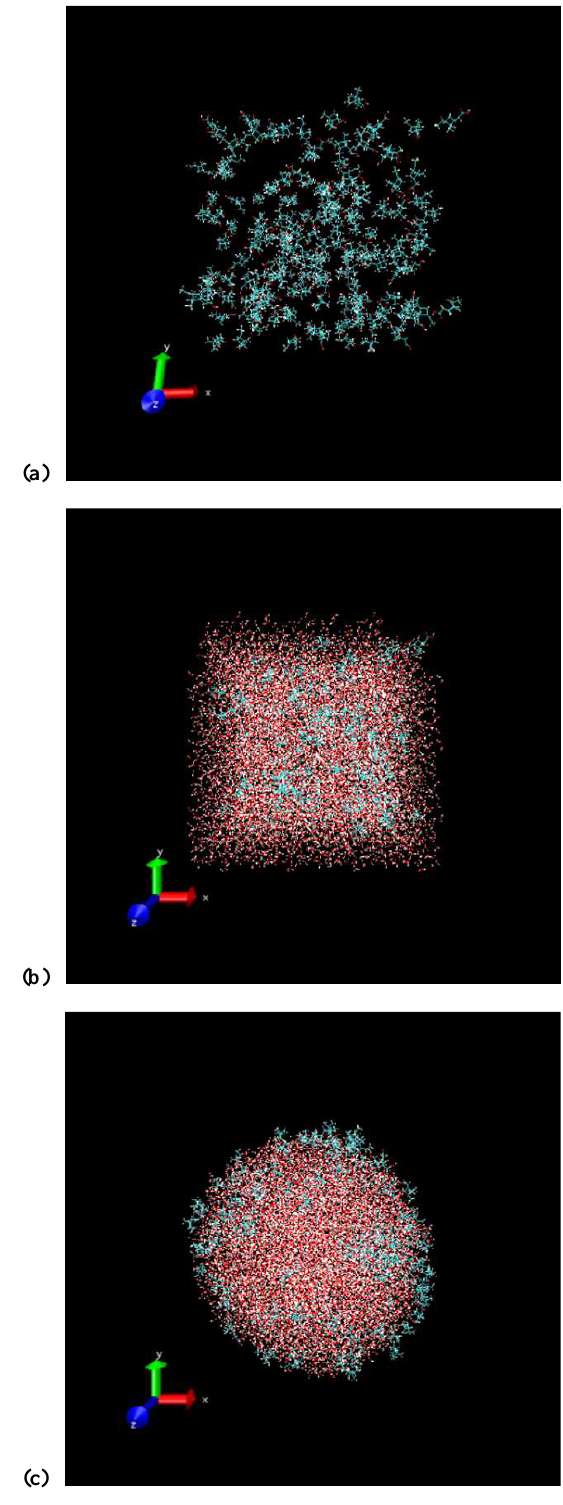
Table 1 . Aggregation formation in the simulations of nanoaerosol systems. Fig. 2. (a) Molecules randomly distributed in a cubic box; Fig. 2b. 10000 water molecules Fig. 2c. The system adapts to a (b) 10000 water molecules added; (c) the system adapts to a sphere with surfactants on the surface after 8ns of sphere with surfactants on the surface after 8 ns of simulation.